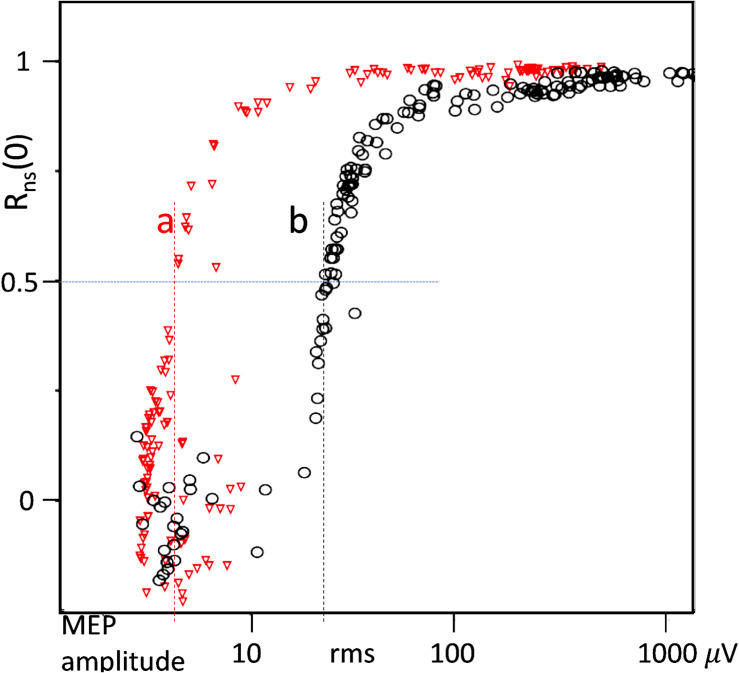
Cross correlation Rns(0) between needle versus surface-electrode signals n(t) and s(t) of MEPs obtained from muscle MEP versus TES-voltage curves of the standard measuring procedure (Journée et al., 2015, 2018). (a) Moderate surface-electrode noise level: background noise needle 2.5 μV; surface: 18 μV RMS and (b) high surface-electrode noise level showing its masking effects on lower MEP amplitudes. Background-noise needle: 3.5 μV; surface: 108 μV RMS. The noise levels are read at correlations of 0.5 and depicted by the vertical dashed lines.